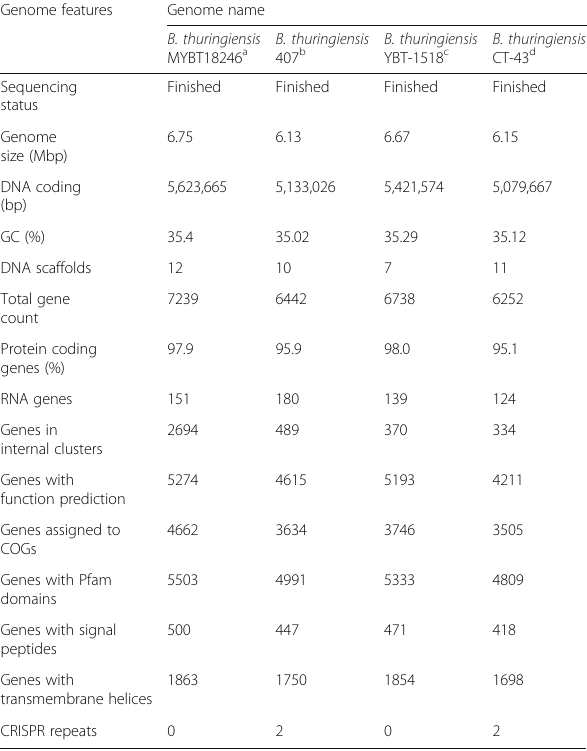
Table 6 General genome features of B. thuringiensis MYBT18246 and close